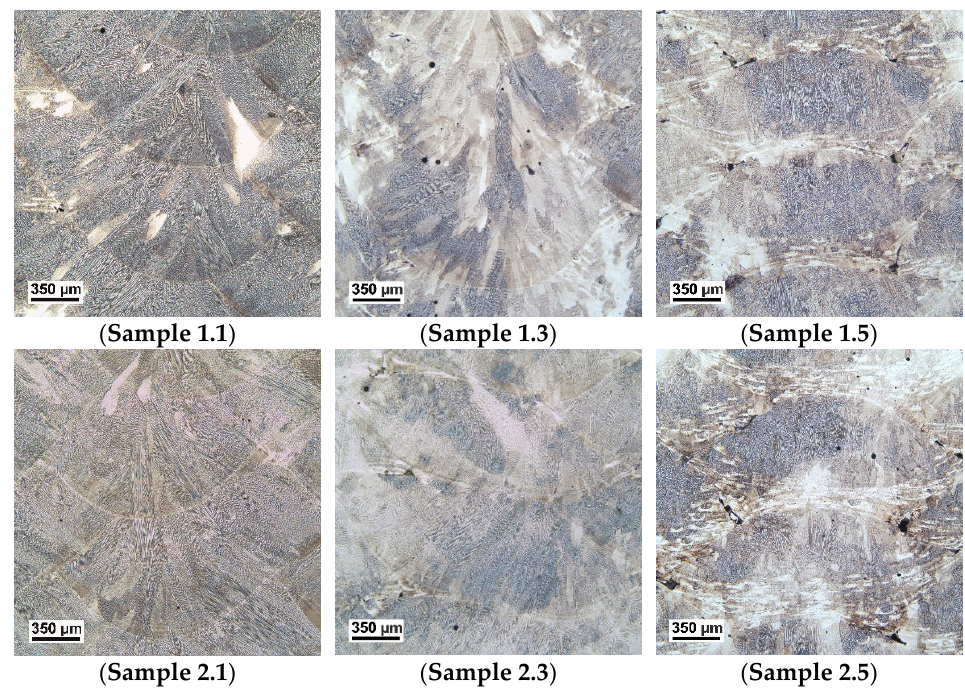
Figure 6. Macrostructure of samples with different modes, laser power in the range of P = 2600 W ( Sample 1.1 ; Sample 2.1 ), P = 2200 W ( Sample 1.3 ; Sample 2.3 ), P = 1800 W ( Sample 1.5 ; Sample 2.5 ).